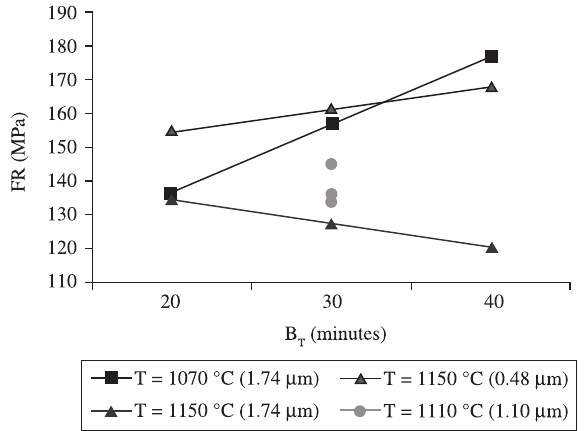
Figure 3. Flexural resistance value (FR) as a function of the Brazing time (BT) for different Brazing Temperature (T) and Ti layer thickness.